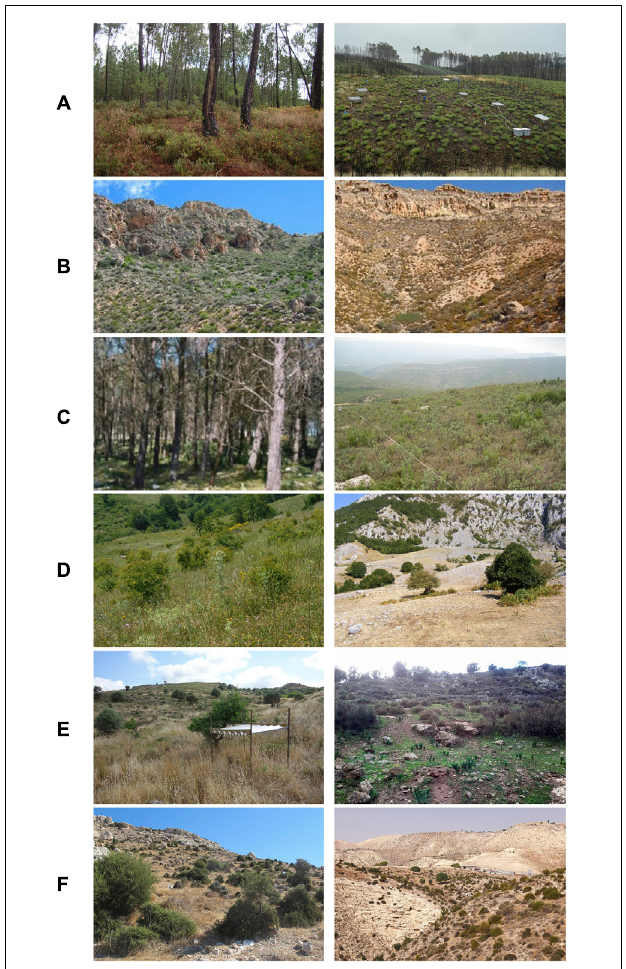
FIGURE 3 | Images of non-degraded and degraded locations in each of the study sites. Panels (A–F) correspond with the locations on the map in Figure 2 . (A) Várzea study site images: non-degraded (left) and degraded (right) photos by O. González-Pelayo. (B) Albatera-Santomera study site images: non-degraded (left – photo by S. Bautista) and degraded (right – photo by S. Bautista). (C) Ayora study site images: non-degraded (left – photo credit: CEAM Foundation) and degraded (right– photo credit: CEAM Foundation). (D) Castelsaraceno study site images: non-degraded (left) and degraded (right), photos by R. Salvia. (E) Messara study site images: non-degraded (left – photo by E. van den Elsen) and degraded (right – photo by I. Daliakopoulos). (F) Randi study site images: partly degraded (left – photo by M. Christophorou) and degraded (right – photo by E. van den